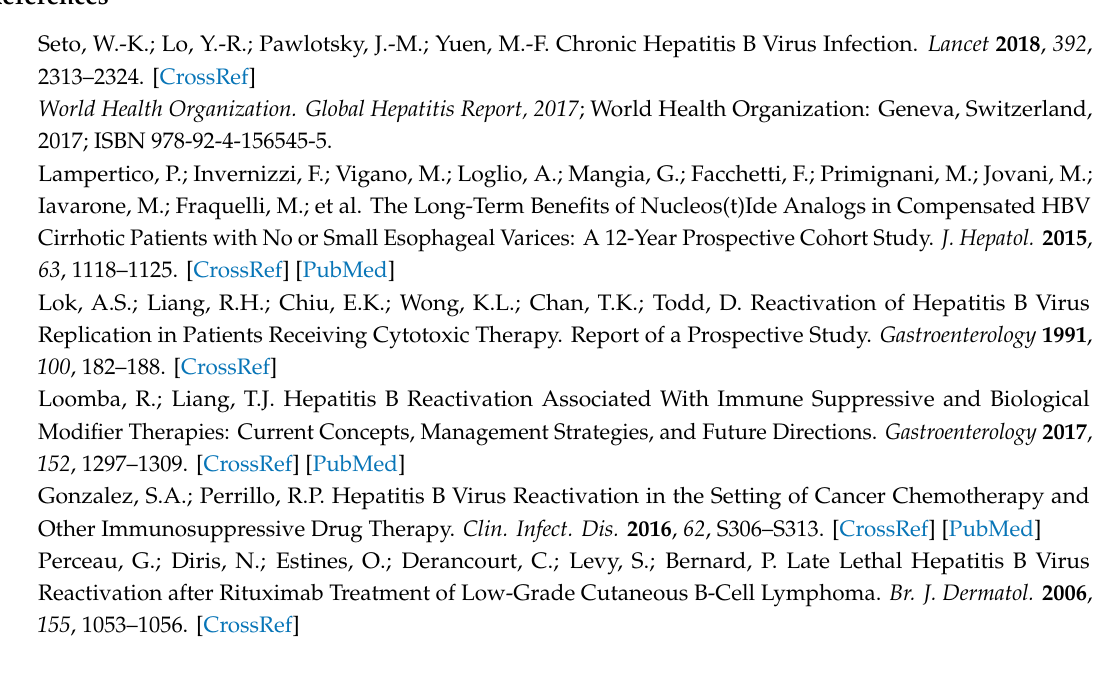
Figure S1: Experimental schematics; Figure S2: Experimental schematics for shRNAs transfections; Figure S3: Experimental schematics for transcriptional activation of ATM and